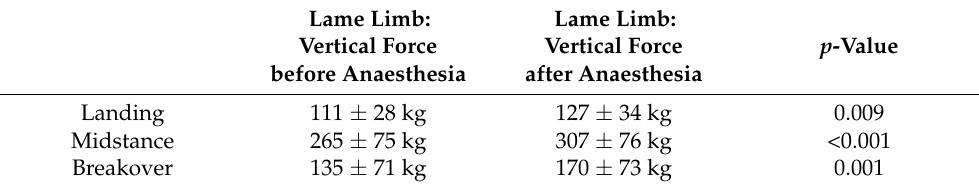
Table 6. Pairwise comparisons of the vertical force in kg on the lame limb before and after anaesthesia during landing, midstance, and breakover.